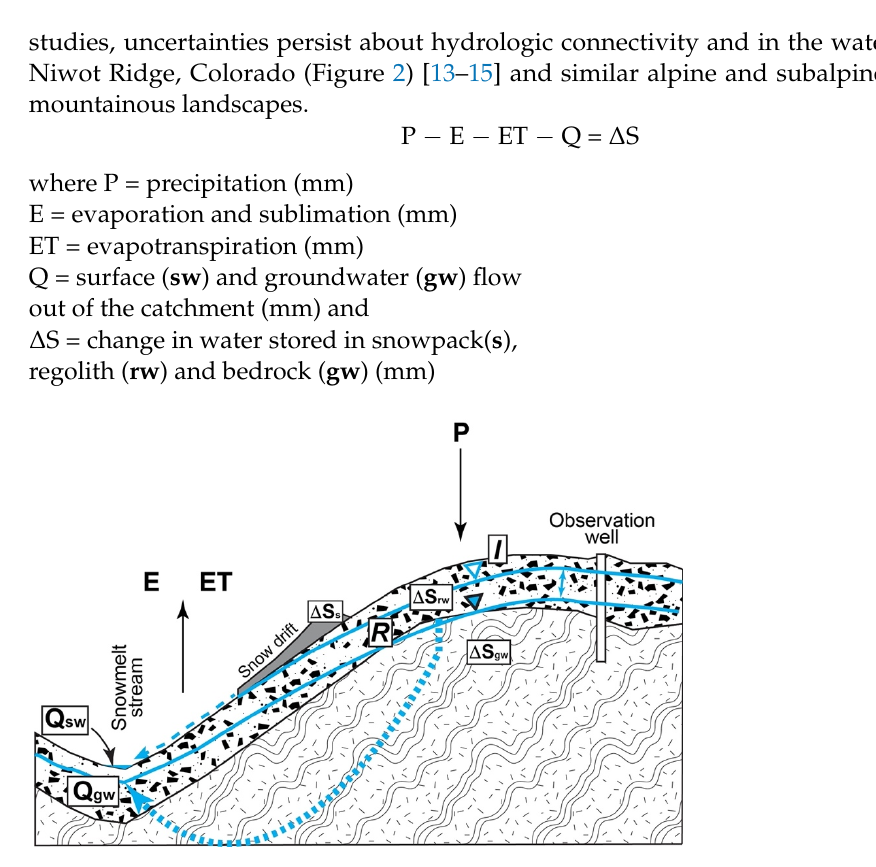
Figure 1. Conceptual model showing water flow and storage in the alpine zone. Flow includes precipitation (P), evaporation (E) and evapotranspiration (ET), and discharge (Q) as surface water ( sw ) and groundwater ( gw ). Storage ( S ) includes snow ( s ), regolith water ( rw ) and groundwater ( gw ). Infiltration ( I ) is water that enters the soil, and recharge ( R ) is flow that reaches the water table in the alpine and subalpine critical zone where several meters of regolith cover bedrock. Seasonal positions of the water table and a groundwater flow line are shown in blue. Infiltration through the streambed is not portrayed.